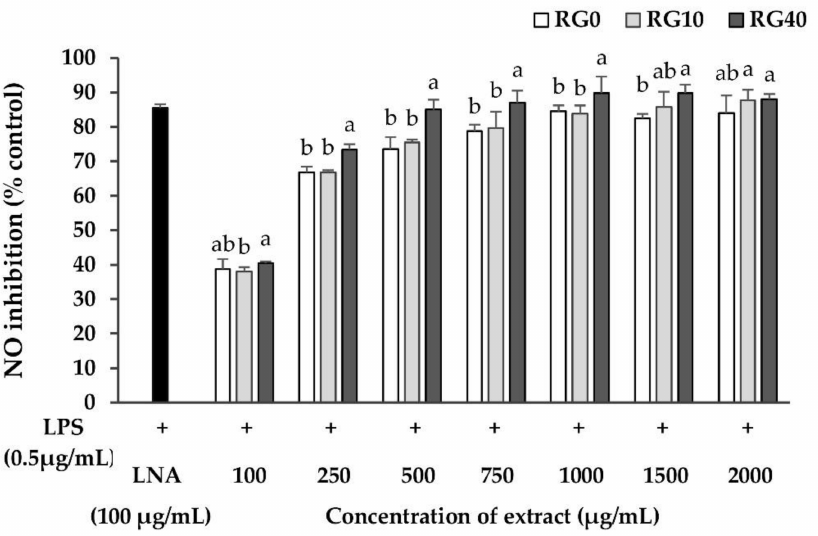
Figure 7. The effect of extracts on the inhibition of nitric oxide (NO) in RAW264.7 murine macrophage cells after co-incubation of LPS from E. coli (0.5 µ g/mL) with various concentrations of extracts from 100–1000 µ g/mL for 24 h using LNA as a positive control (100 µ g/mL): RG0; ricegrass juice extract (control), RG10; ricegrass juice fortified with 10 mg Se/L extract, RG40; ricegrass juice fortified with 40 mg Se/L extract. Data are means ± standard deviation (SD). Different letters indicate significant differences ( p < 0.05) in Duncan’s significant differences